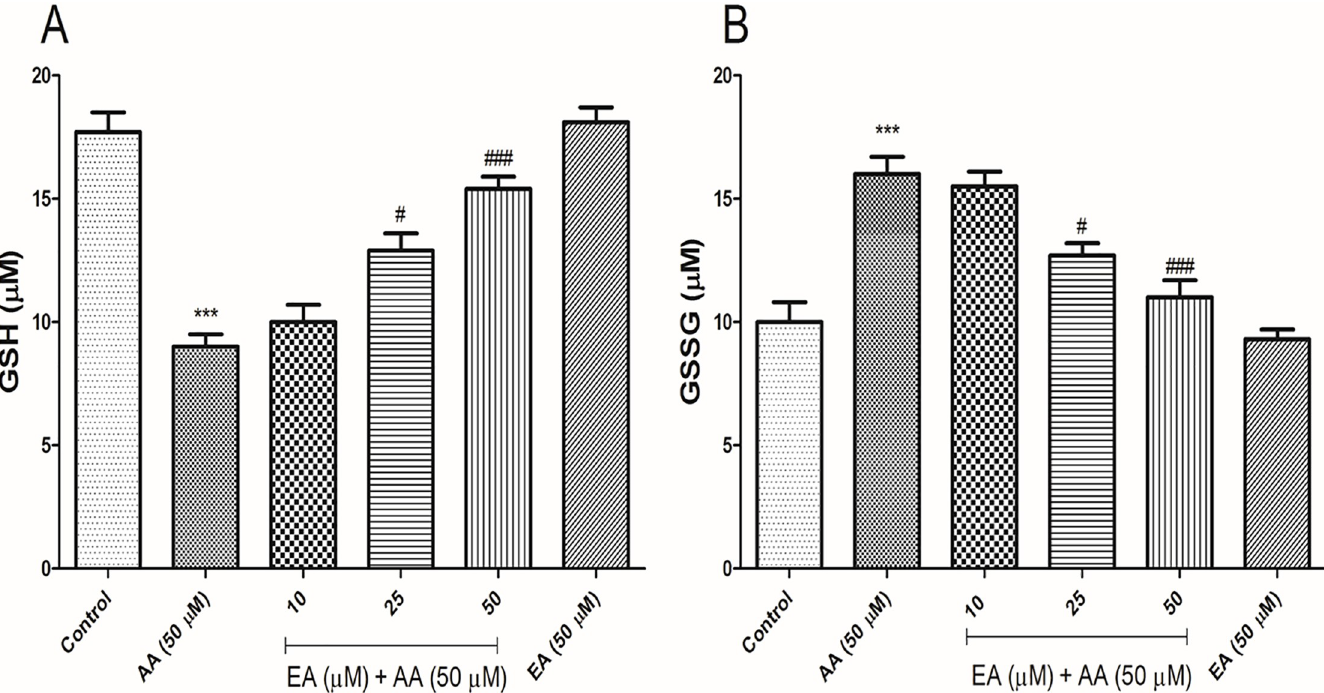
Fig 5. Addition of ellagic acid decreases AA-induced glutathione depletion in human lymphocytes. (A) GSH content significantly decreased in AA-treated human lymphocytes while cotreatment EA (50 μ M) with AA obviously increased the GSH content in human lymphocytes. (B) Also, AA significantly increased the GSSG content in human lymphocytes after 4 h of exposure while EA (50 μ M) significantly decreased the GSSG content in the presence of AA. All experiments were repeated at least three times. ��� p < 0.001: Control versus AA; #p < 0.05, ###p < 0.001: AA + EA versus AA-treated human lymphocytes ANOVA, Tukey’s test.